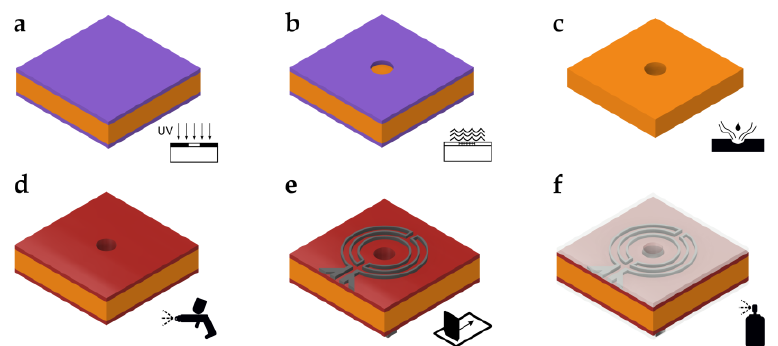
Figure 3. Fabrication process of the dosage plate. ( a ) UV-light exposure. ( b ) Development of photoresist. ( c ) Wet etching. ( d ) Insulation of metal plate. ( e ) Screen printing of heaters and sensors. ( f ) Application of superhydrophobic coating.